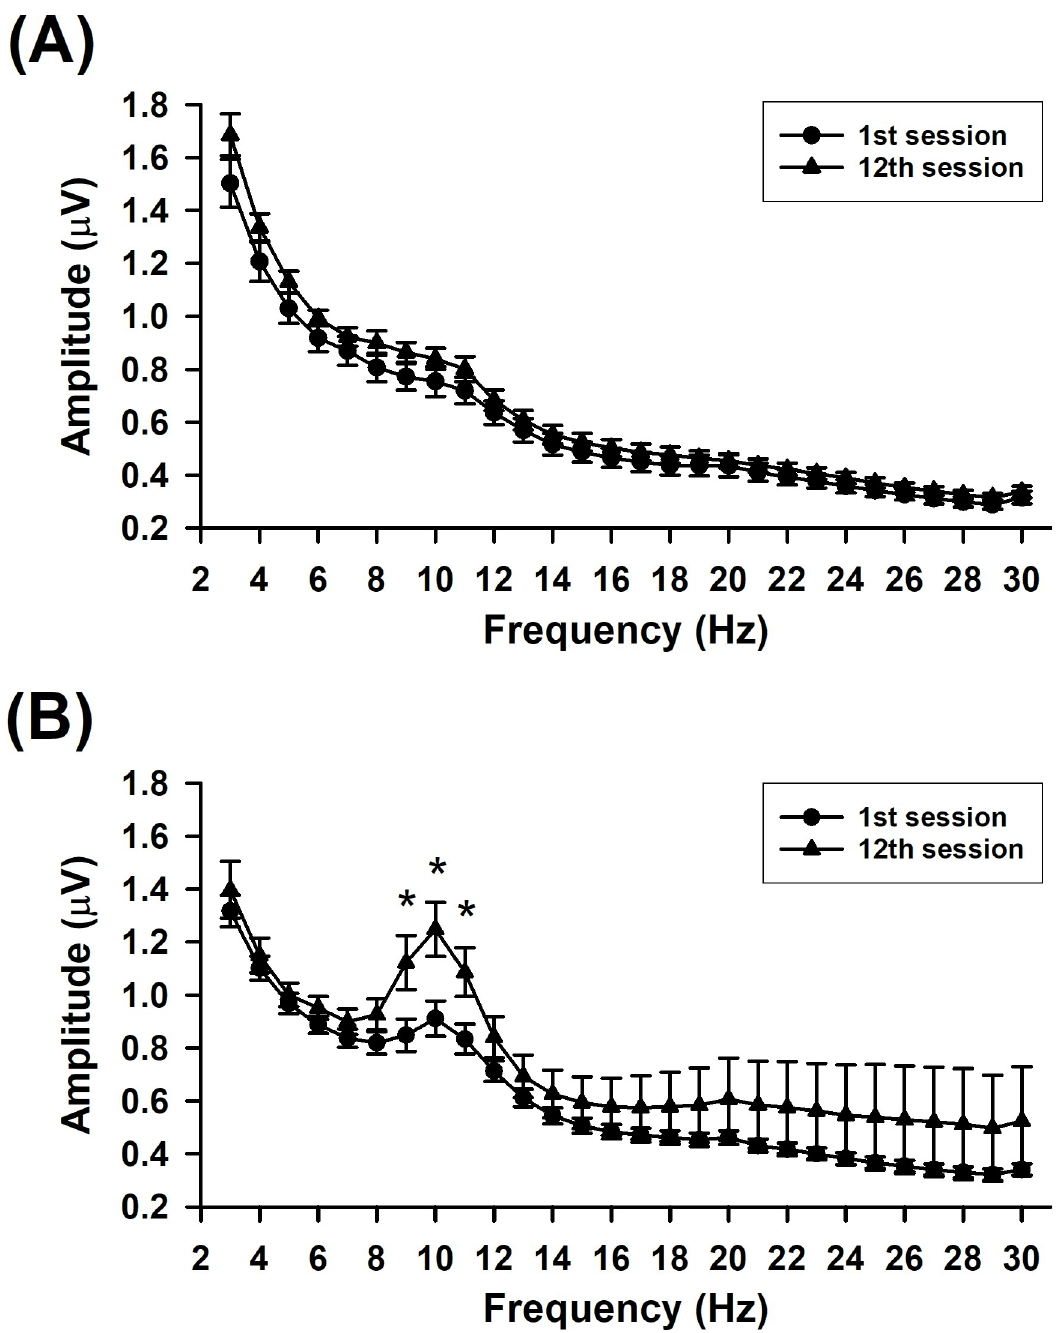
Fig 2. Amplitude spectra of the 1st and 12th sessions in the two groups. The (A) Ctrl group and (B) Alpha group. � p < 0.05 vs. the 1st session. successful alpha events of the alpha (324.24 ± 22.27, range: 224–606) and fixation blocks (55.03 ± 3.97, range: 11–89) was also observed (t = 12.53, p < 0.001). These data indicated that “responders” had learned to successfully induce alpha activity in the alpha block. The success- ful alpha events were further processed through four different averaging methods. Finally,